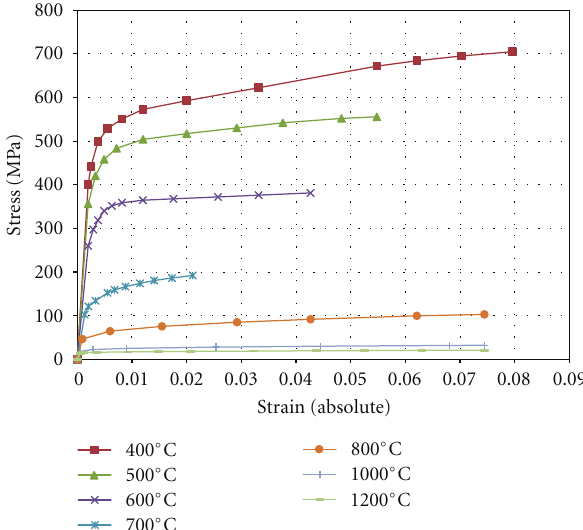
Figure 3: Steel 20 MnMoNi 55: true stress-strain curves up to uniform elongation (400 ◦ C–1200 ◦ C) derived from measured data.